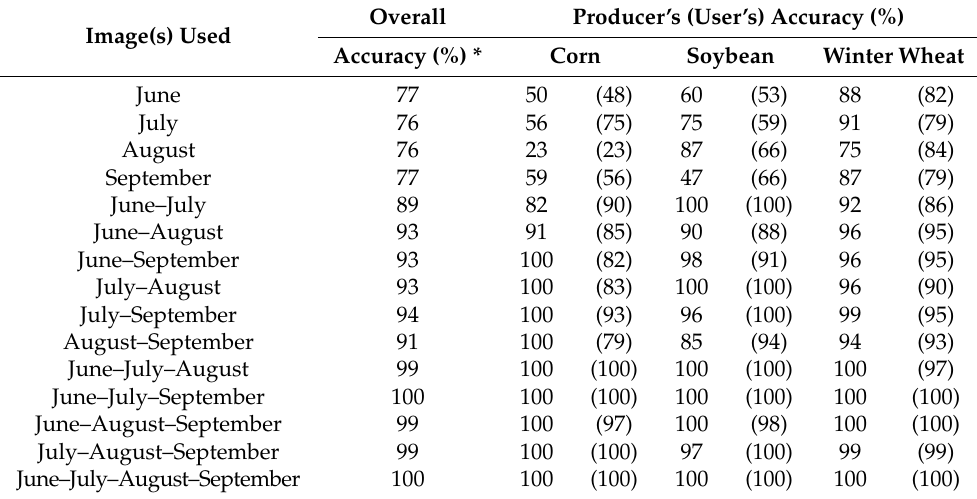
Table 7. Hyperion Support Vector Machine Accuracies. Classification accuracies for Support Vector Machine separating three leading world crops (corn, soybean, and winter wheat) using 15 Hyperion narrowbands. Analysis was conducted across 3 years, for 4 months throughout each growing season when available; these accuracies are averages across those 3